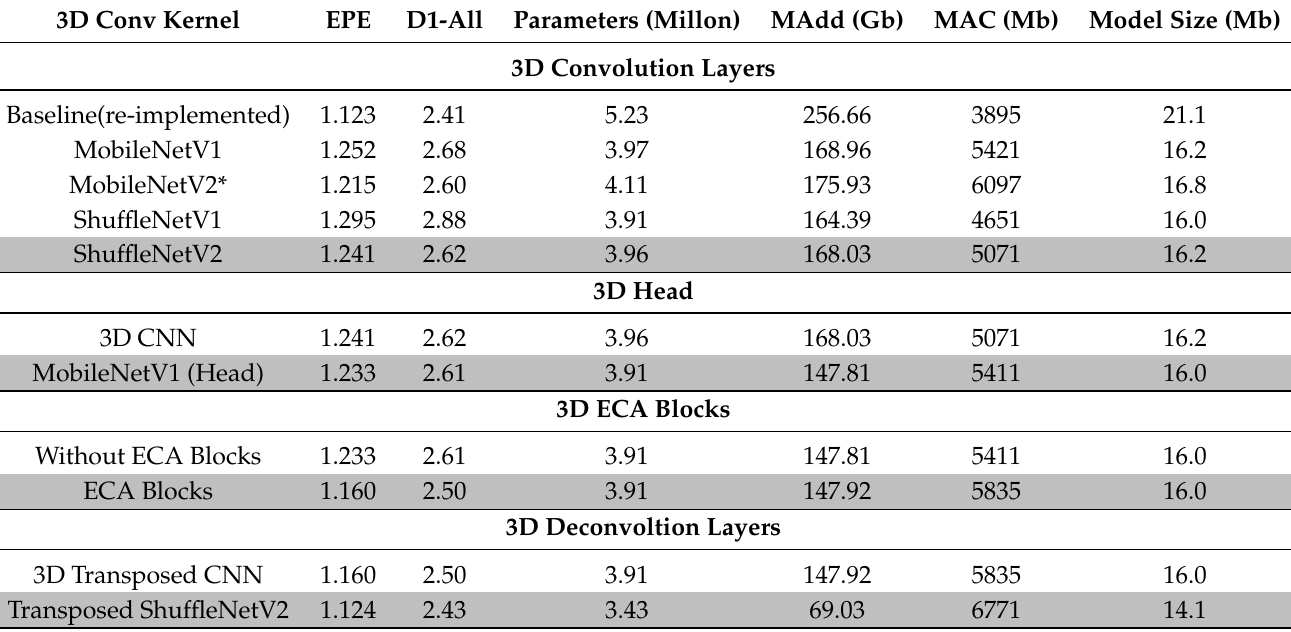
Table 3. Experiments for 3D convolution kernels on PSMNet. We calculate the MAdd with 512 × 256 resolution as input. EPE is the end-point-error on the Scene Flow dataset. D1-all denotes the evaluation of the KITTI 2015 leaderboard. MobelNetV2* denotes implementation of the kernel with expansion ratio = 2 considering the MAC of the model. At each stage, we select the best 3D convolution kernel (grey line) and optimize it on the model.